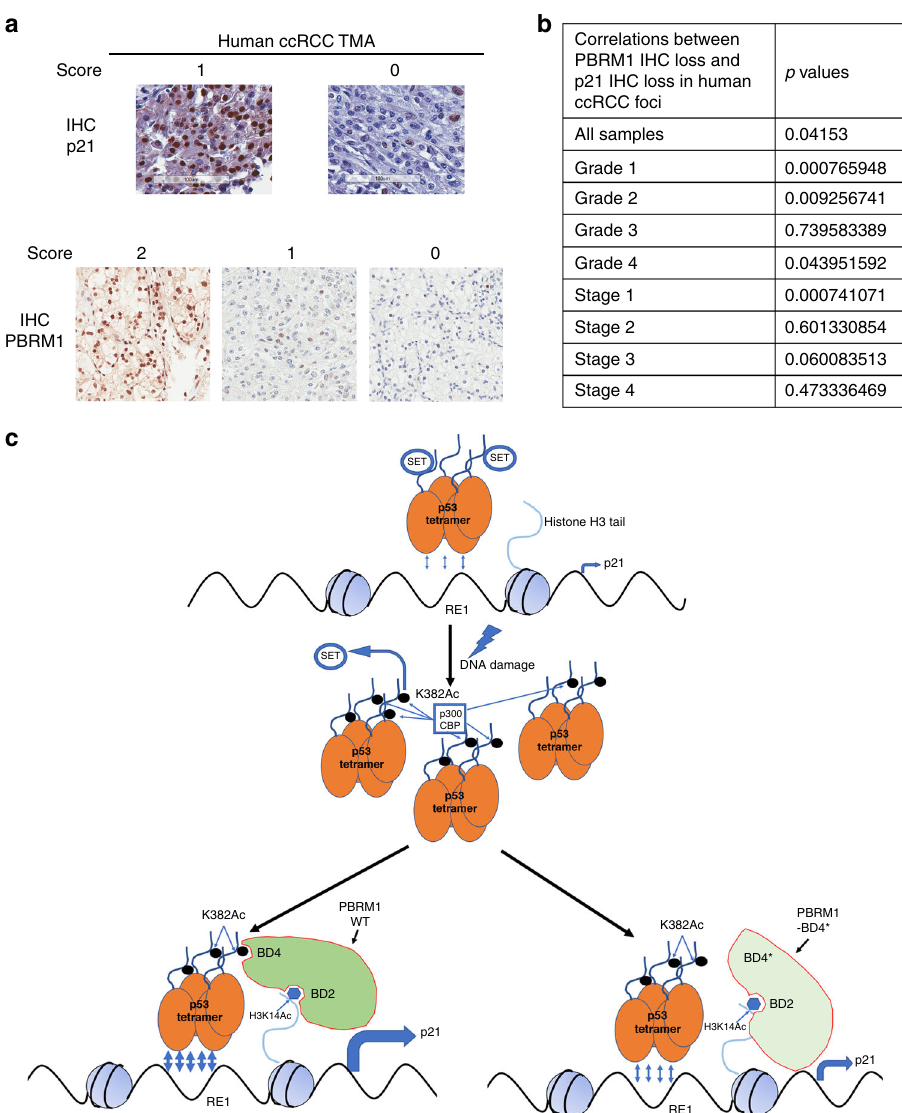
Fig. 7 PBRM1 loss and p21 loss positively correlate in human ccRCC tumors. a 160 ccRCC tumors (40 tumors per stage) were used to generate a tissue microarray (TMA). Four foci from different regions of each tumor were selected. PBRM1 expression was analyzed and scored in our previous report 47,48 ( a , bottom). p21 expression was analyzed and scored in the tumors ( a , top) by a blinded pathologist. Scale bar: 100 μ m. b p -values of correlations between PBRM1 loss and p21 loss in human ccRCC samples. c A model depicting how PBRM1 may regulate tumor growth in ccRCC through recognition of p53 K382Ac. Source data are provided as a Source Data fi